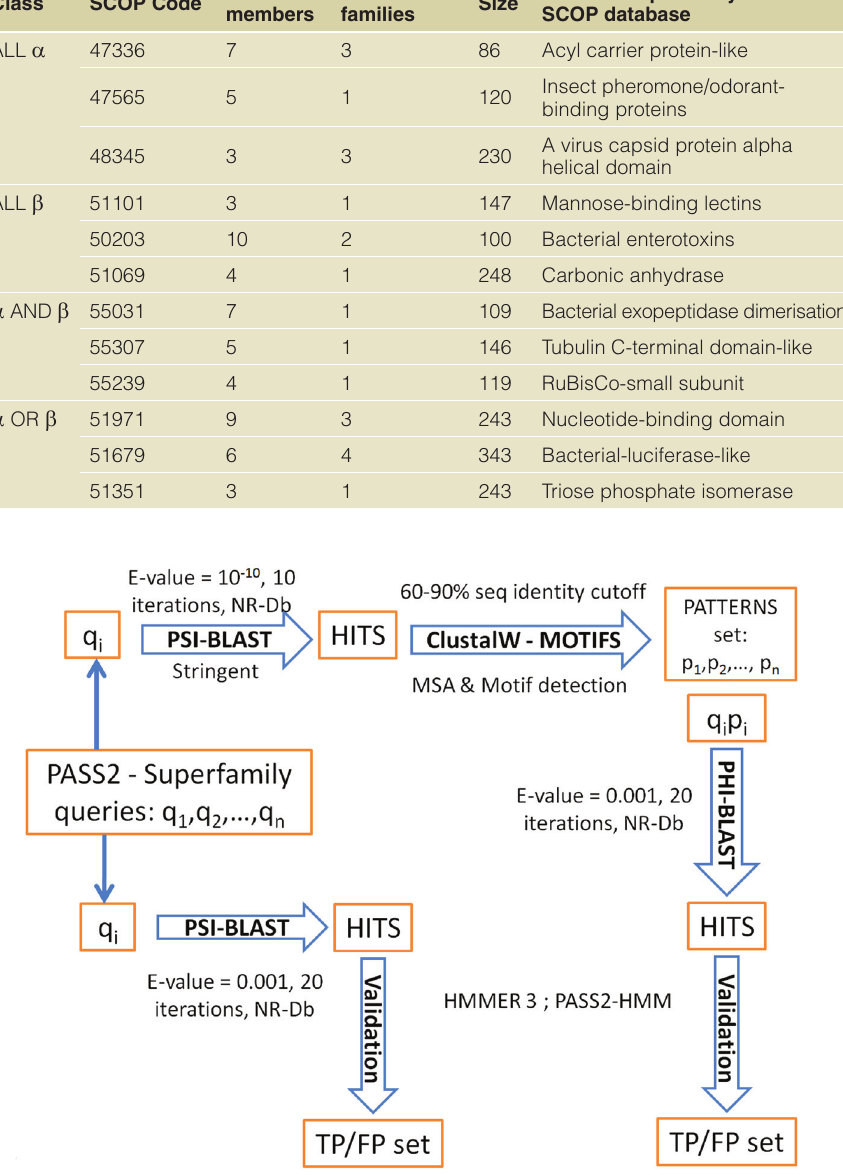
Figure 1. Flowchart of workflow for the sequence